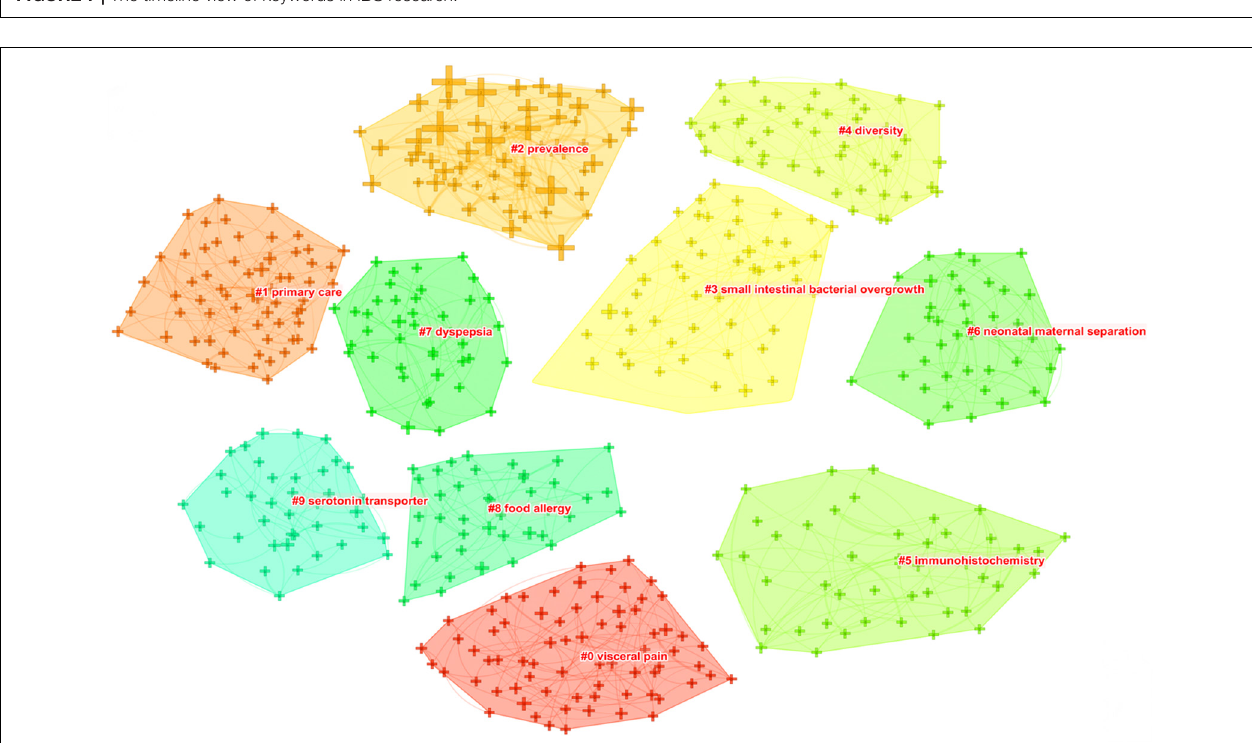
FIGURE 8 | The keyword clustering knowledge map of IBS